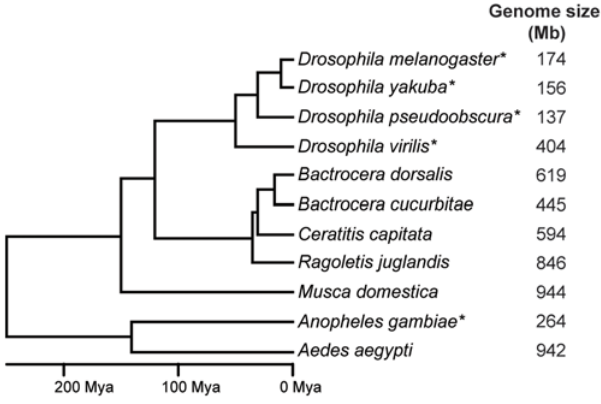
Figure 3. Tephritid genomes are larger than Drosophila genomes. Phylogenetic relationships and approximate divergence times of several dipteran species (left) are shown along with experimentally determined haploid genome sizes (right), drawn from the Animal Genome Size Database [1] ( Drosophila spp , M. domestica , A. aegypti , A. gambiae ), and our own experiments ( Bactrocera spp , C. capitata , R. juglandis ). While some groups ( Drosophila , Anopheles ) have undergone substantial reduction in genome size, many closely related species including the tephritids described here have substantially larger genomes. Asterisks indicate species with available whole-genome sequence.